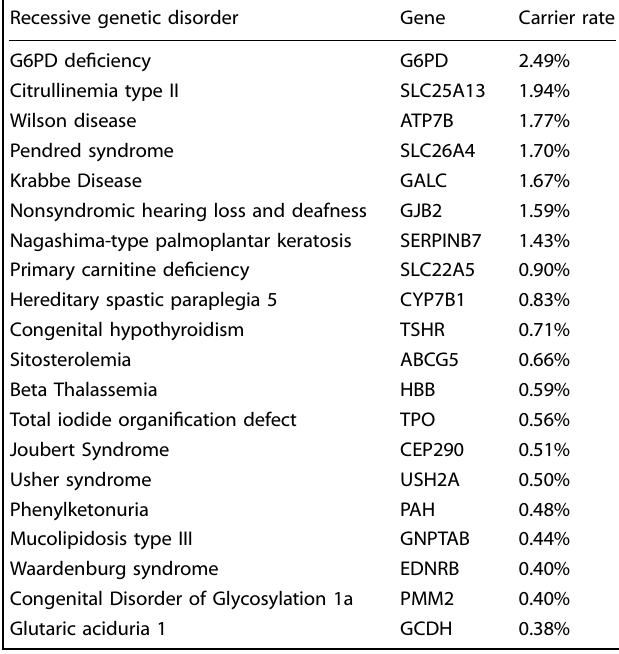
Table 4. Cancer susceptibility conditions with the highest fraction of affected individuals in the